Question: Write the caption for this figure.
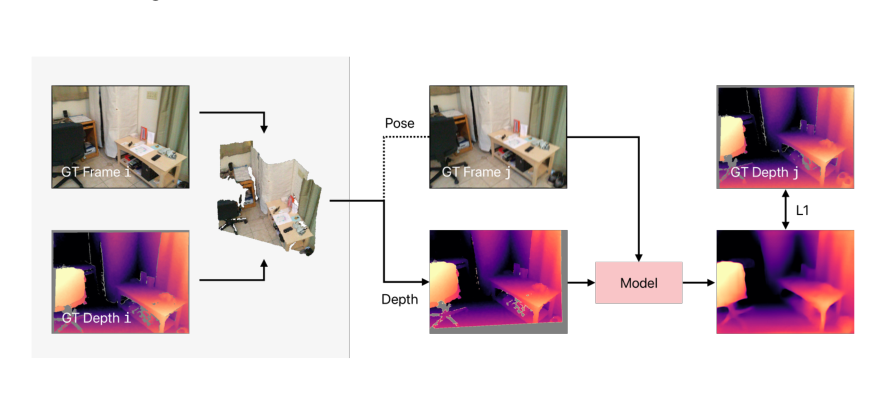
Answer: Overview of our scene consistency evaluation approach. Assume a scene is described by a set of views {v1, v2, . . . } with associated images, depth maps, and camera poses, where the overlap of two views is described by a function ϕ(vi, vj). For a given view pair (vi, vj) with ϕ(vi, vj) ≥τ, we generate a representation, e.g., a point cloud, from the ground-truth (GT) data for vi. Then, we render the representation from the view point of vj. We feed the corresponding ground-truth image and the representation’s depth into the model under consideration to extrapolate the missing depth. Finally, we calculate the mean absolute error between the result and the ground- truth depth for vj, only considering those regions that were extrapolated.